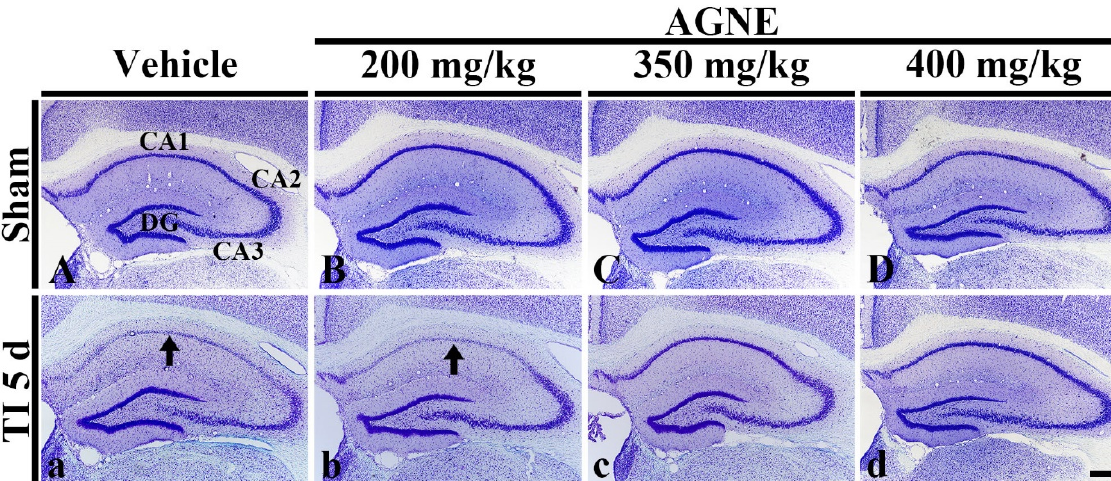
Figure 3. Cresyl violet (CV) histochemistry in the hippocampus of the sham/vehicle ( A ), sham/AGNE 200–400 mg/kg ( B - D ), transient ischemia (TI)/vehicle ( a ), TI/AGNE 200–400 mg/kg ( b – d ) groups at 5 days after TI. In the TI/vehicle and TI/200 mg/kg AGNE groups, CV stainability is weakened in CA1 (arrows) at 5 days after TI. On the other hand, in the TI/350 and 400 mg/kg AGNE groups, CV dyeability is similar to that in the sham/vehicle group. DG, dentate gyrus ( n = 7 in each group). Scale bar = 400 μ m.